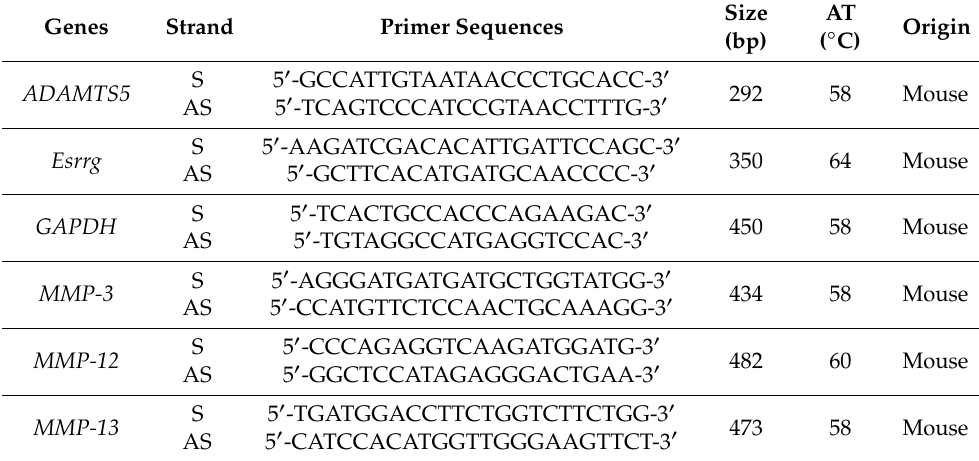
Table 1. PCR primers and